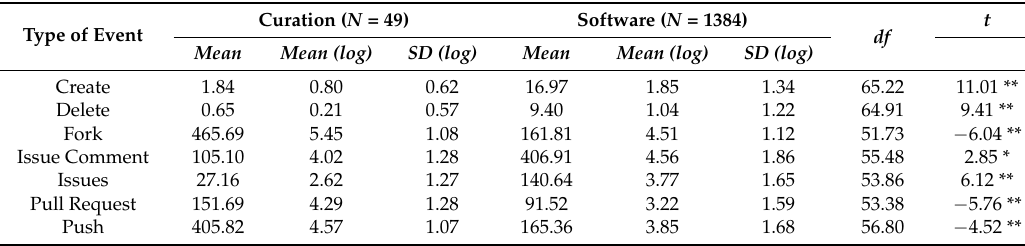
Table 1. Independent sample t -tests to compare the log-transformed mean of the number of seven types of activities between curation projects and software